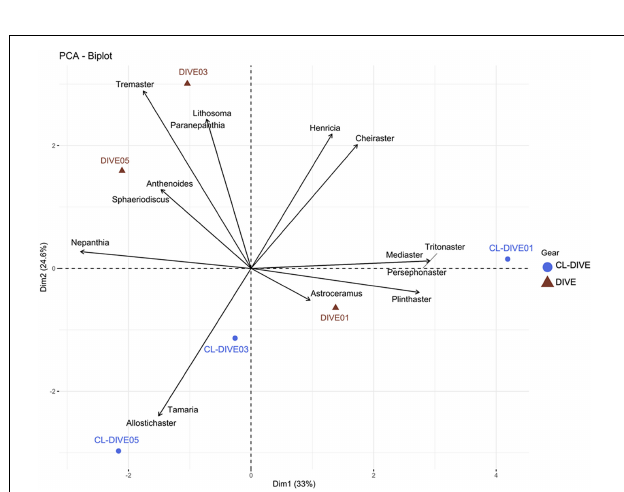
FIGURE 9 | Comparison of echinoid assemblages between imagery (dive) and sampling along dive (cl-dive) along volcanic island slopes (Mayotte) (72.9% of variance on first two PCs). Principal Component Analysis (PCA) of Hellinger-transformed presence/absence echinoid data at genus rank.